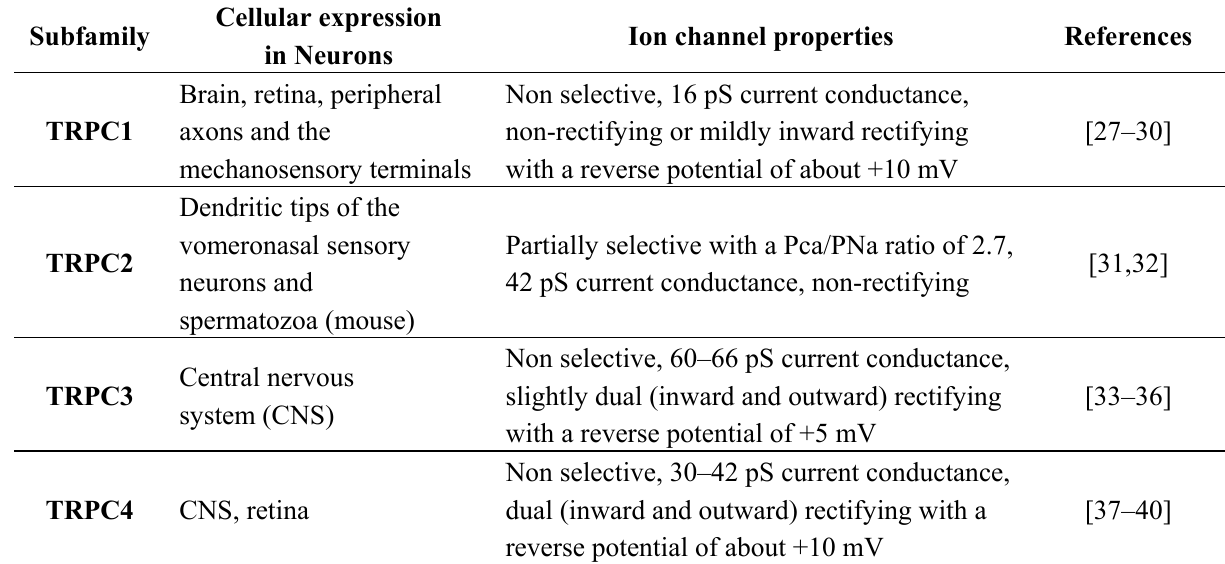
Table 1. Expression of the TRPC channel and its properties in neuronal cells.